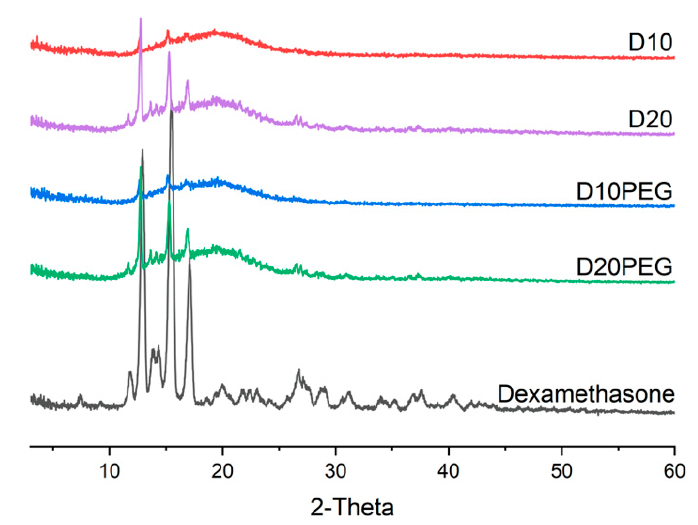
Figure 5. X-ray powder diffraction patterns of dexamethasone and DLP 3D printed formulations.